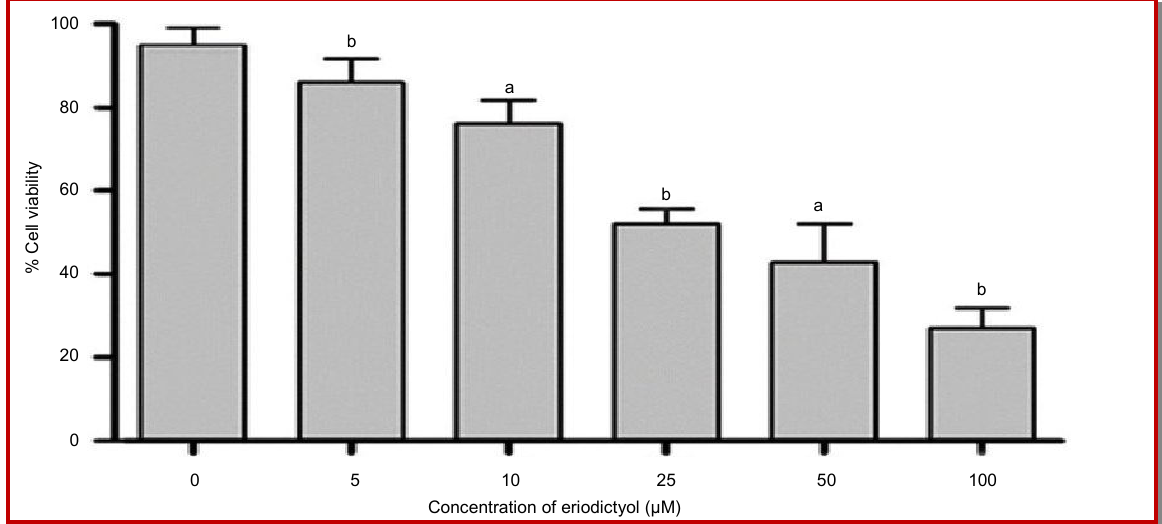
Figure 2: Cytotoxic effect of eriodictyol in human liver cancer cells (Hep-G2). Data are shown as mean ± SD of three independent experiments. a p<0.05, b p<0.01, vs 0 µM